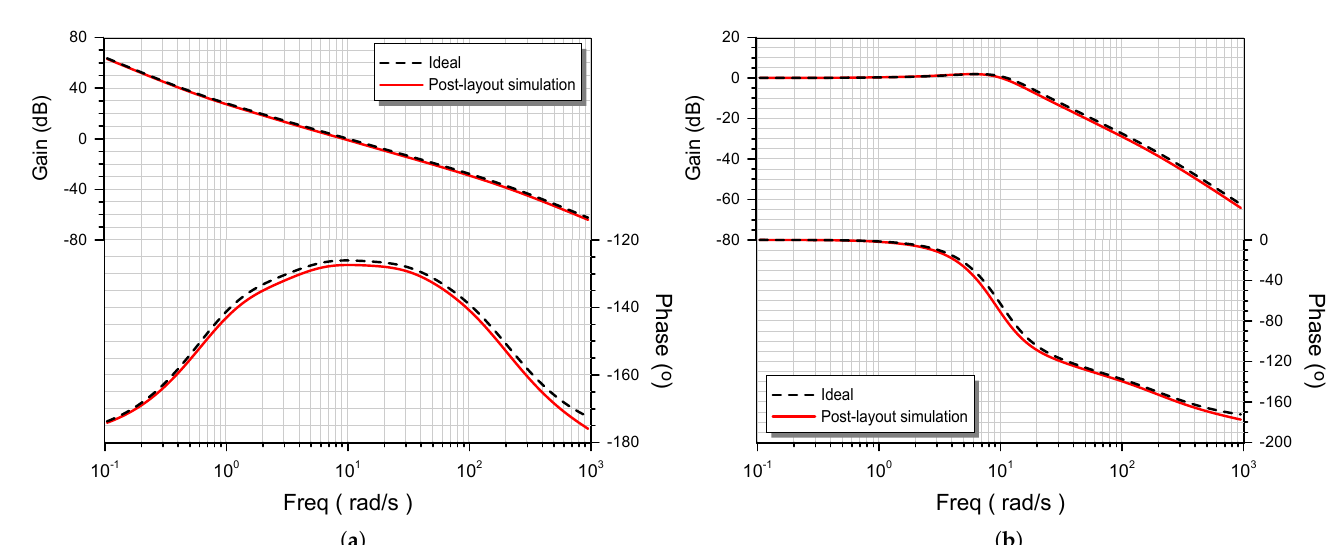
Figure 7. Post-layout ( a ) open-loop and ( b ) closed-loop gain and phase frequency responses of the system compensator-plant.